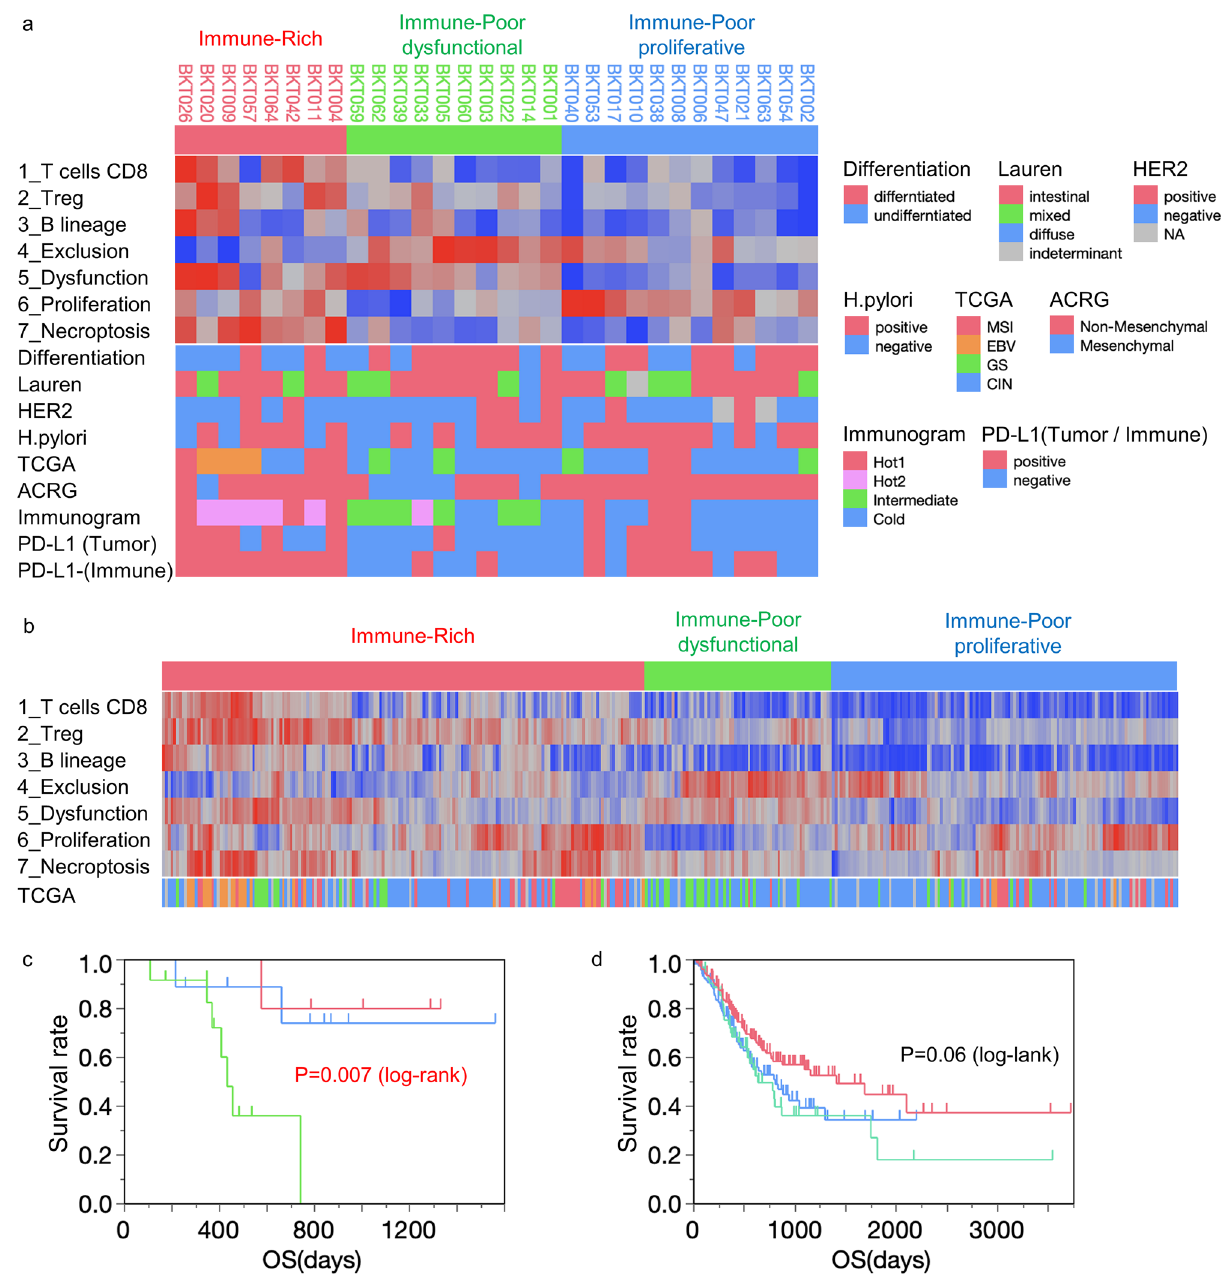
Figure 4. Transcriptome-based TME analysis with selected reliable gene sets in gastric cancer. ( a ) Hierarchical cluster analysis was performed in our 30 gastric cancer patients (BKT Cohort). The patients’ characteristics are shown in Table 1 and Supplementary Table S1. Degree of tumor differentiation, Lauren classification, HER2 status, Helicobacter pylori infection, TCGA subtype, the Asian Cancer Research Group (ACRG) Mesenchymal subtype 15 , Sato’s immunogram classification (IGS) 8 and PD-L1 IHC are displayed at the bottom. ( b ) Gastric cancer patients from the TCGA cohort (n = 375) were subjected to hierarchical clustering with 7 transcriptome- based TME analyses. The patients’ characteristics are shown in Tables S12-1 and S12-2. The molecular classification of TCGA is indicated at the bottom. Survival analysis for Immune-Rich (IR, red), Immune-Poor dysfunctional (IPd, green) and Immune-Poor proliferative (IPp, blue) groups. The Kaplan–Meier method and log-rank test were performed in BKT cohort ( c ) and TCGA cohort ( d